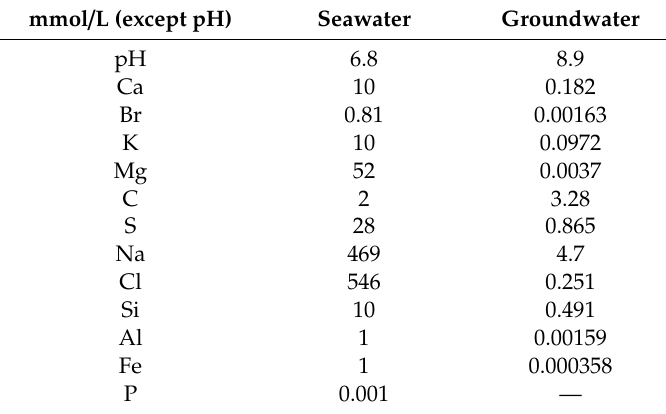
Table 3. Compositions of the starting fluids